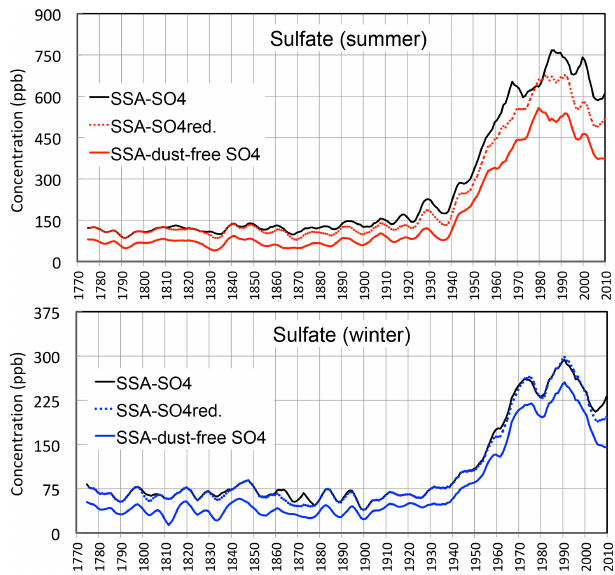
Figure 9. ELB half-year summer and winter sulfate trends from 1774 to 2010 (the first SSA component with a 5-year time window; see text). The black lines refer to raw sulfate values, the dashed lines to sulfate means calculated after removal of dust samples (SO 4red . ), and the solid red and blue lines to sulfate values after having cor- rected SO 4red . values from the background dust contribution (see Sect. 3). Samples suspected to be impacted by volcanoes were re- moved.